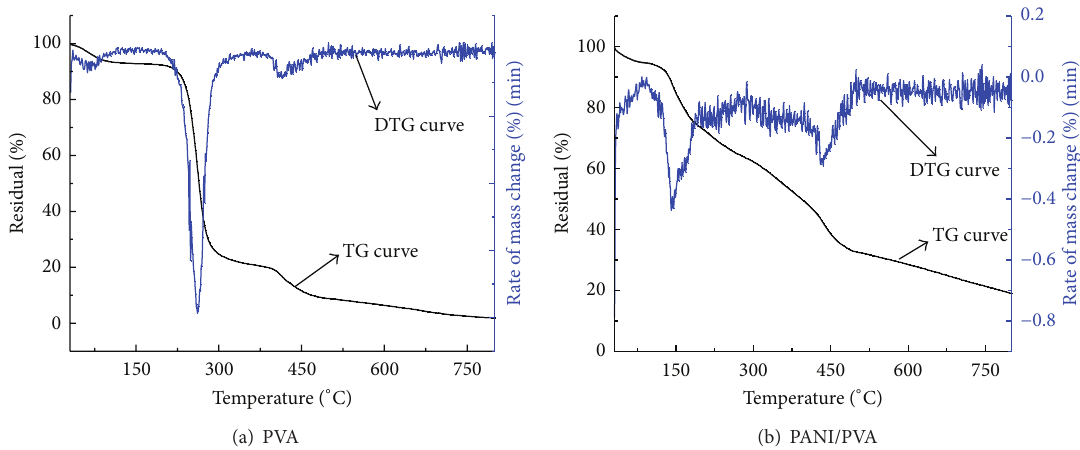
Figure 5: The curve of PANI/PVA composite membrane about thermal gravimetric